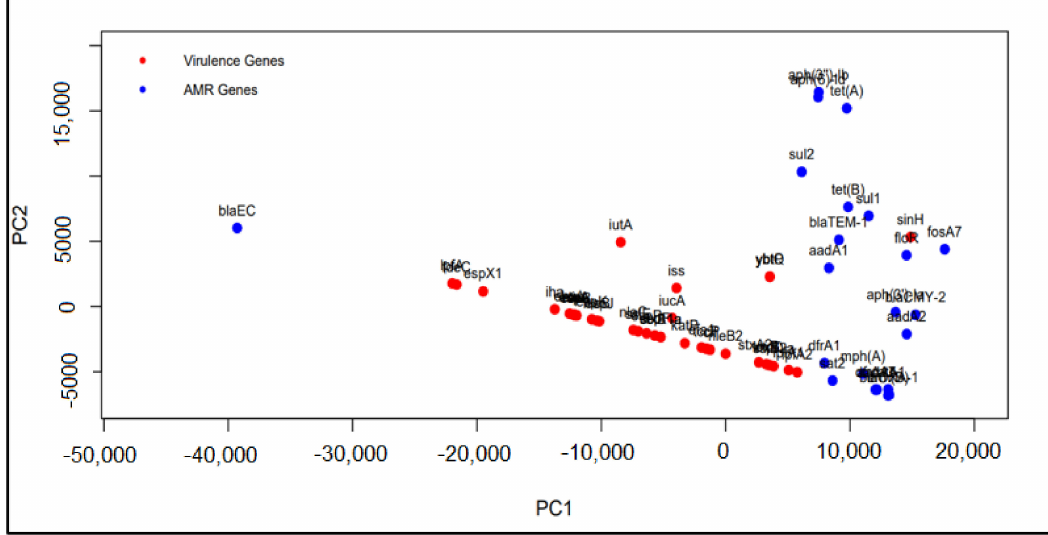
Figure A2. A principal component analysis representation of the important virulence genes and AMR genes from historic samples of the